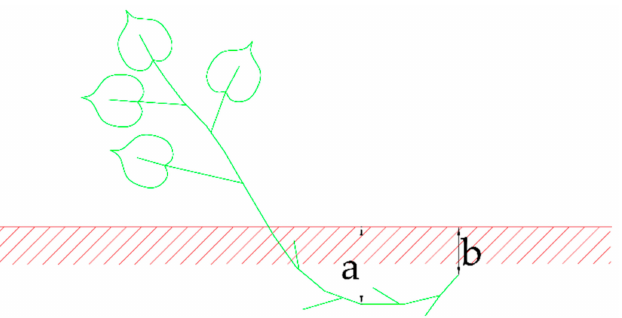
Figure 1. Schematic diagram of the boat-bottom-shaped insertion method: a is the node depth in the seedling middle, b is the seedling root